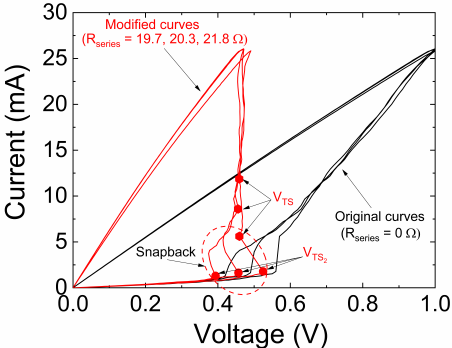
Figure 2. Current versus voltage for some resistive switching cycles. The original measured curves are shown in black, the modified curves in red, the corresponding series resistances are also shown. See the points marked by V TS (threshold set voltages) and V TS curve changes sign, marked with red dots in the modified